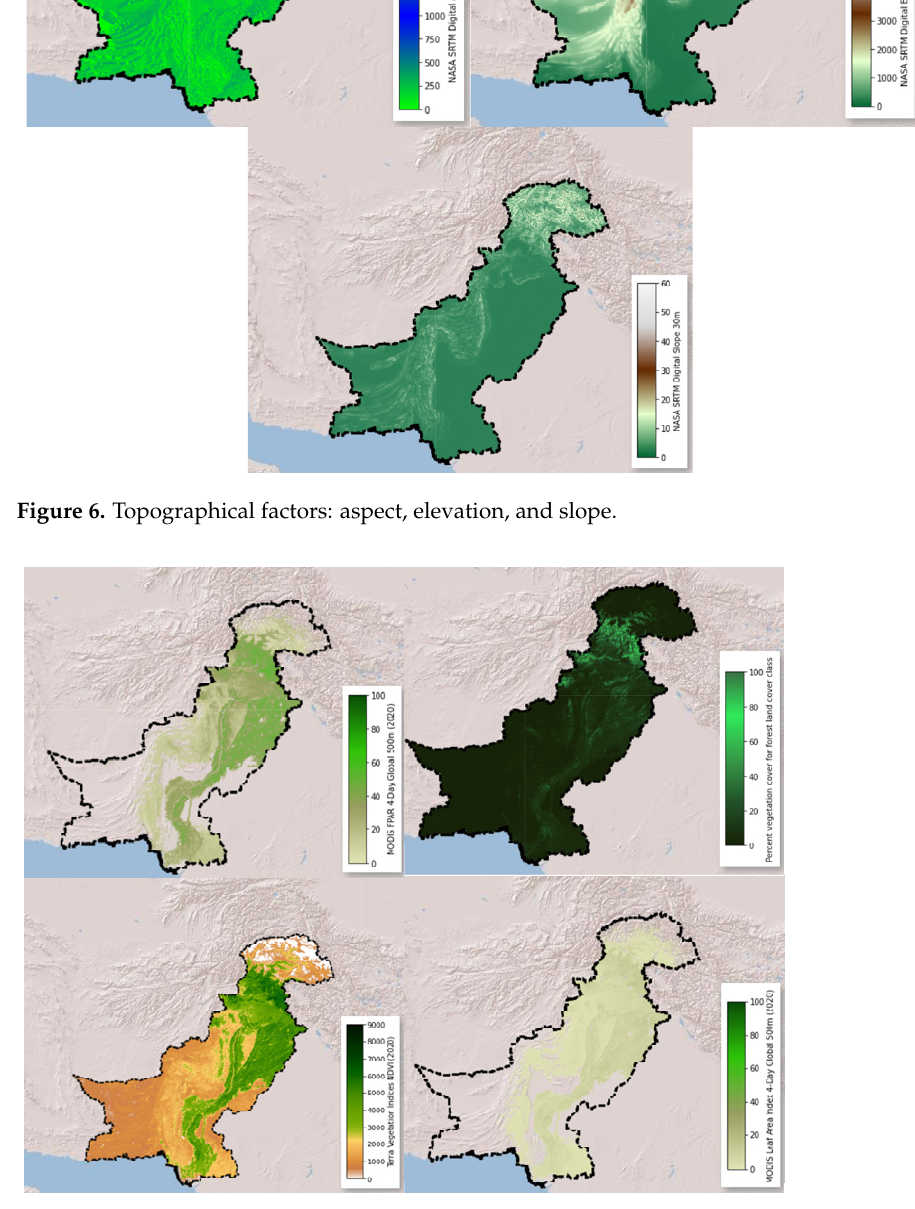
Figure 7. Vegetation factors: FPAR, tree cover, NDVI, and LAI.